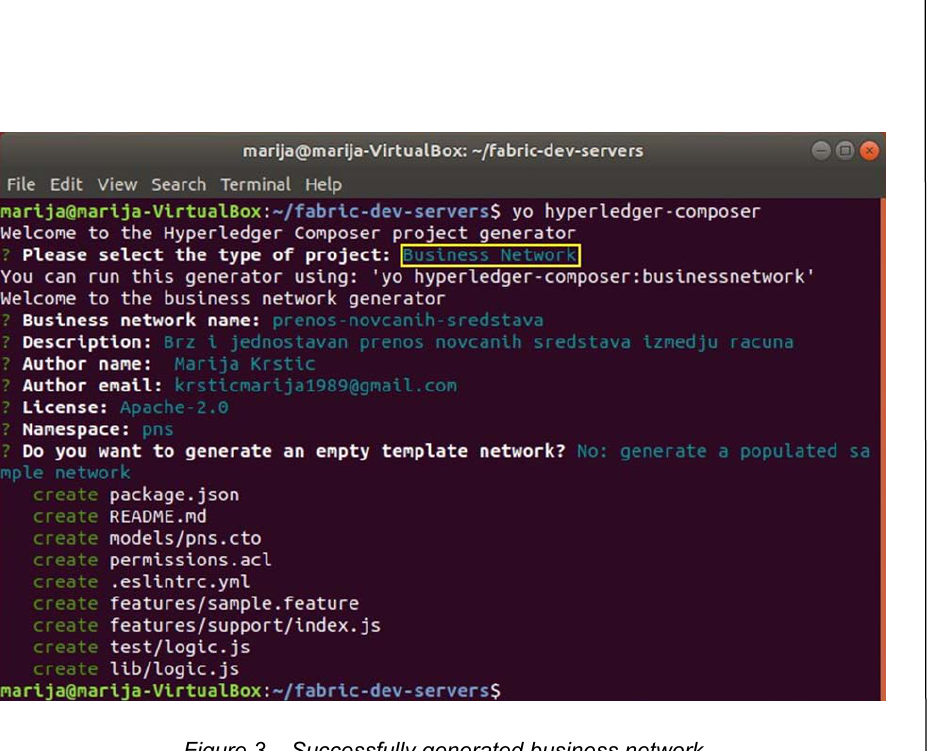
Figure 3 – Successfully generated business network Рис . 3 – Успешно созданная бизнес - сеть Слика 3 – Успешно генерисана пословна